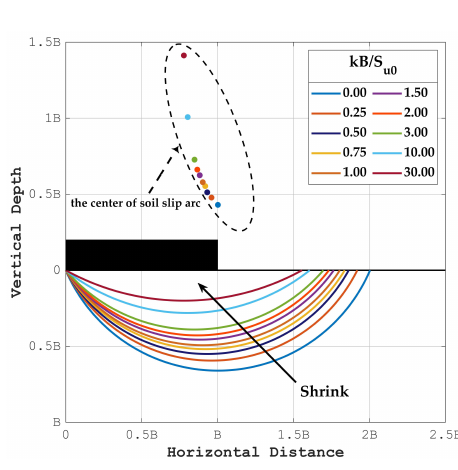
Figure 5. Slip circle surfaces and associated centers of various non-homogeneity